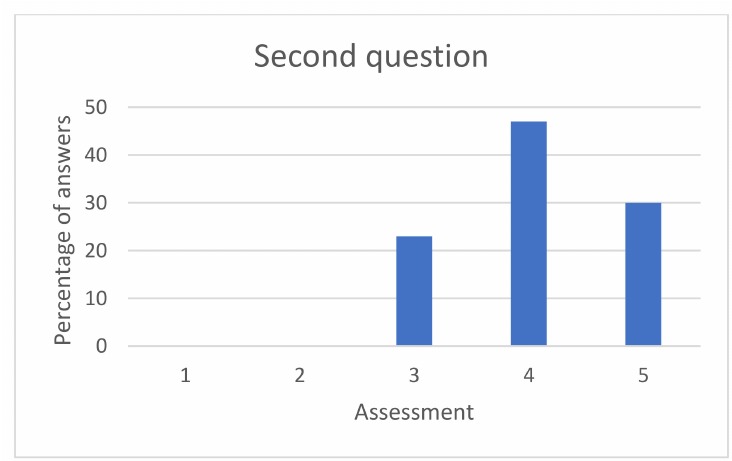
Figure A3. Results of question 2.